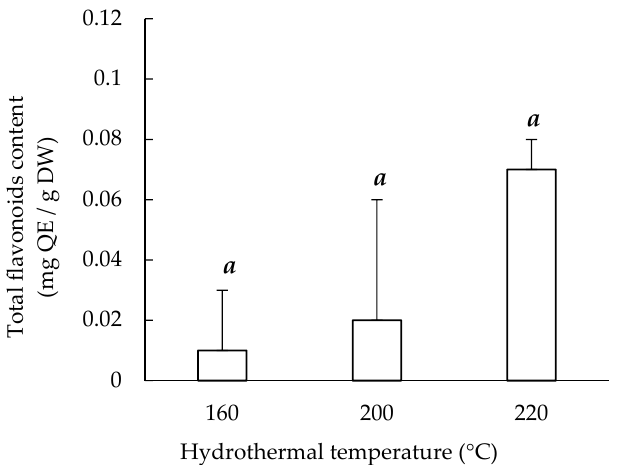
Figure 3. Hydrothermal extraction temperature and total flavonoid content of sericin extracts. Means with the same lowercase letters are not significantly different, per LSD test results.